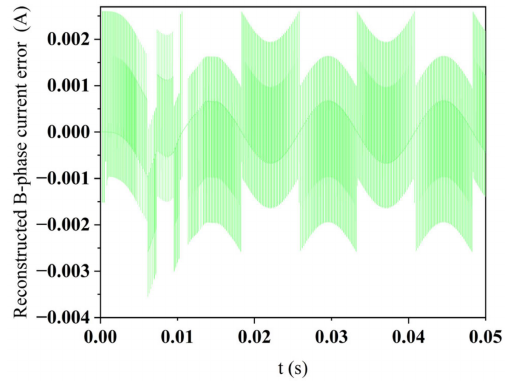
Figure 4. Reconstructed B-phase current error.